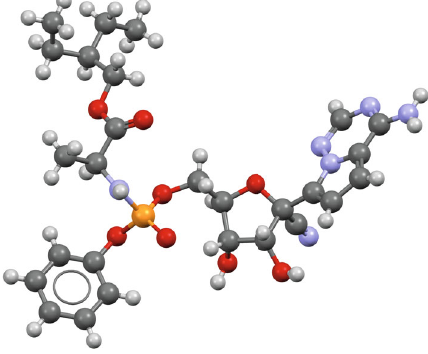
Figure 2: Molecular structure of Remdesivir (GS-5734).